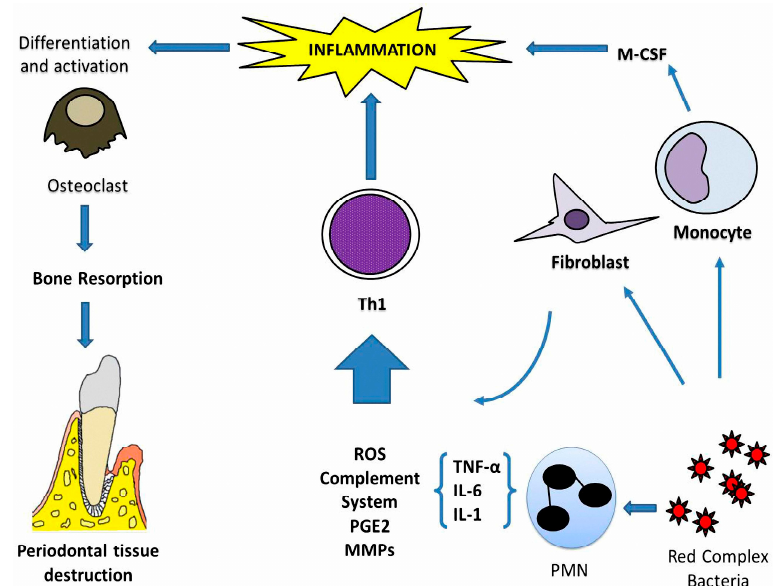
Figure 1. Pathophysiological mechanisms in periodontitis. The presence of red complex bacteria promotes periodontal inflammation in susceptible individuals. Activated polymorphonuclear neutrophils (PMN), fibroblast, and monocytes in the oral cavity induce production of cytokines such as tumour necrosis factor α (TNF- α ), interleukin (IL)-1, and IL-6. The initial function of this inflammation is to protect against bacteria; however, chronic inflammation induces enhanced reactive oxygen species (ROS), complement system, and PGE2 and matrix metalloproteinases (MMPs) such as gelatinase B and collagenase 1. This inflammatory microenvironment induces a Th1 lymphocyte profile, which promotes inflammation and is associated with the maintenance and progression of the lesion. In addition, activated monocytes induce cytokines as M-CSF (macrophage colony-stimulating factor) that promote activation and differentiation of osteoclasts, which are related to resorption of alveolar bone, damage to cementum, and periodontal ligament.